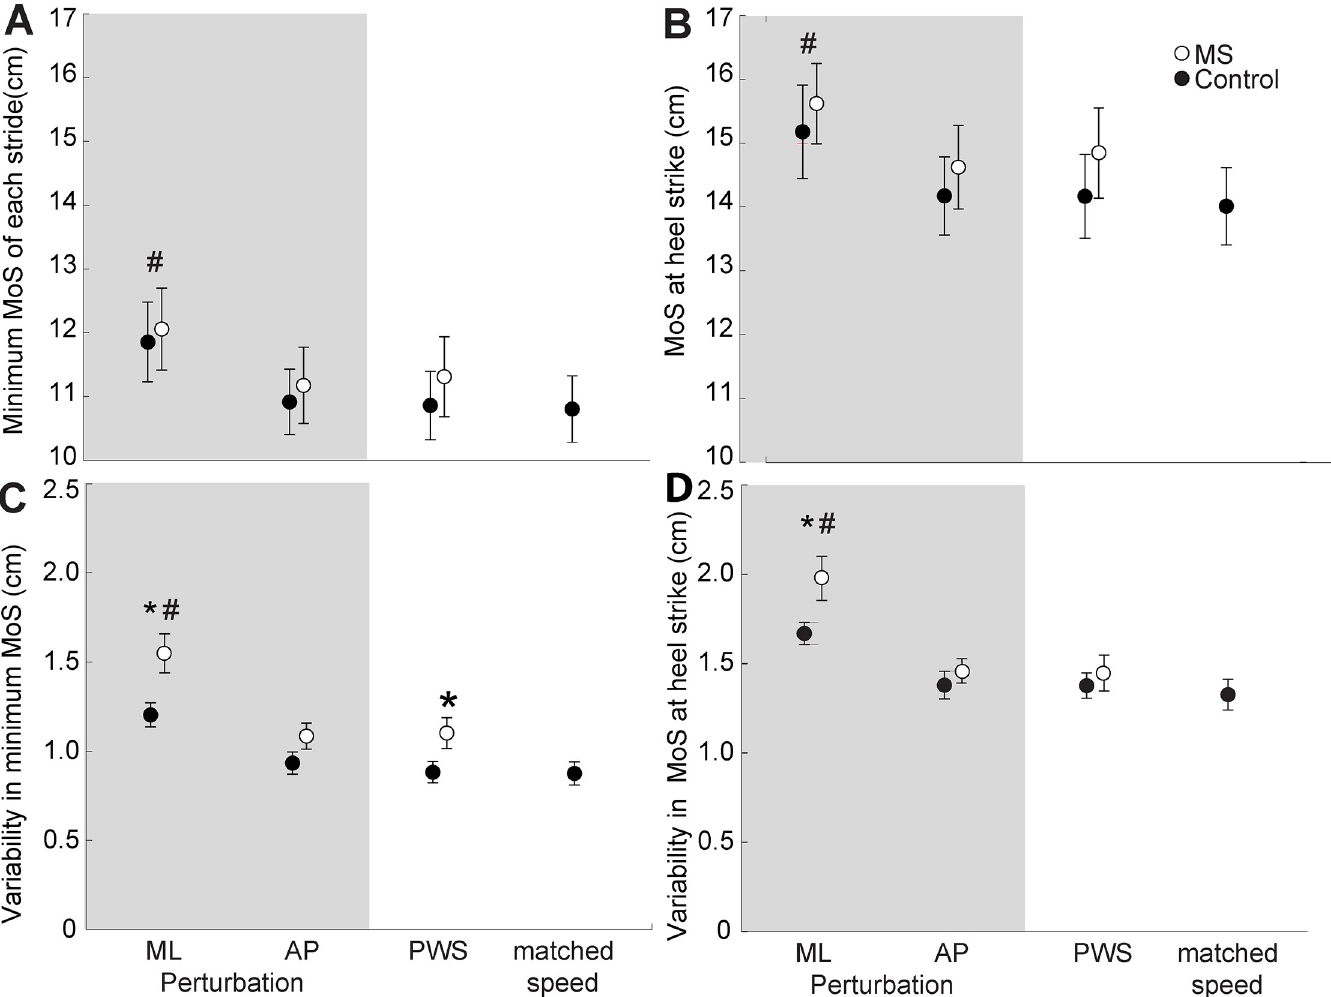
Fig 3. Margin of stability outcomes in PwMS versus age-matched controls across walking tasks. Group average (standard error) minimum lateral margin of stability (MoS) per stride (Panel A), lateral MoS at heel-strike (Panel B) and within subject variability in minimum lateral MoS at minimum MoS (Panel C) and at heel-strike (Panel D) for people with multiple sclerosis (PwMS) and age-matched controls. Single asterisk ( � ) denote significant differences (p < 0.05) between PwMS and controls for a given condition. Pound signs (#) denote significant effects (p < 0.05) of perturbations compared to unperturbed walking (PWS) across both groups. ML: mediolateral; AP: